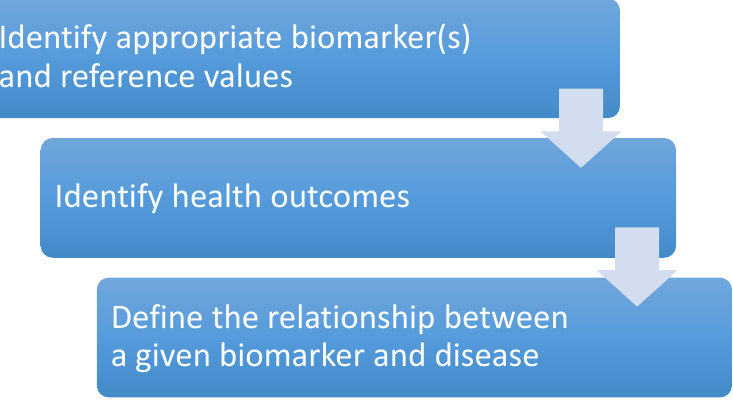
Figure 2. Challenges in monitoring and